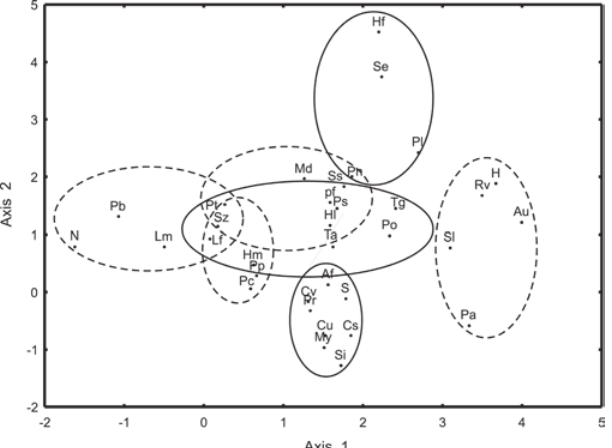
Fig. 5. Ordination of fish species, with respective codes, by detrented correspondence analysis. (---- Cururu lake canal, — Jacaré lake